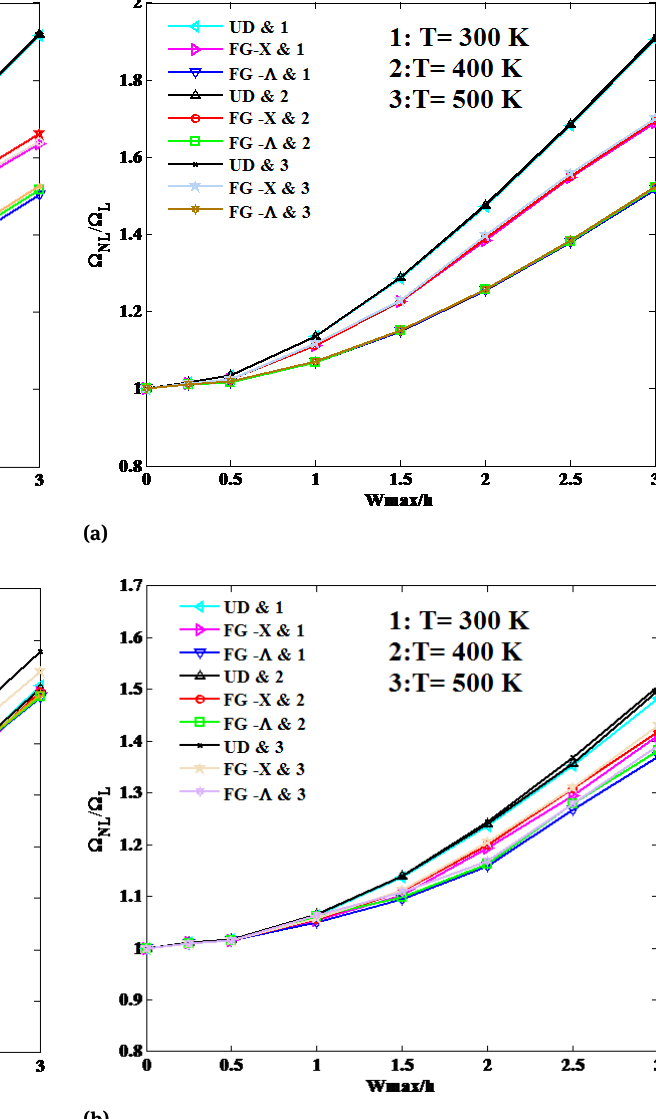
Figure 4: The effect of volume fraction on the amplitude –frequency curves of three types of CNTRC beam without elastically supported foundation (a) and with elastically supported foundation(b) at a / h = 50, V * cn = 0.28 , T = 500 K, k 1 = 10 4 , k 2 = 10 2 , k 3 = 10 3 .